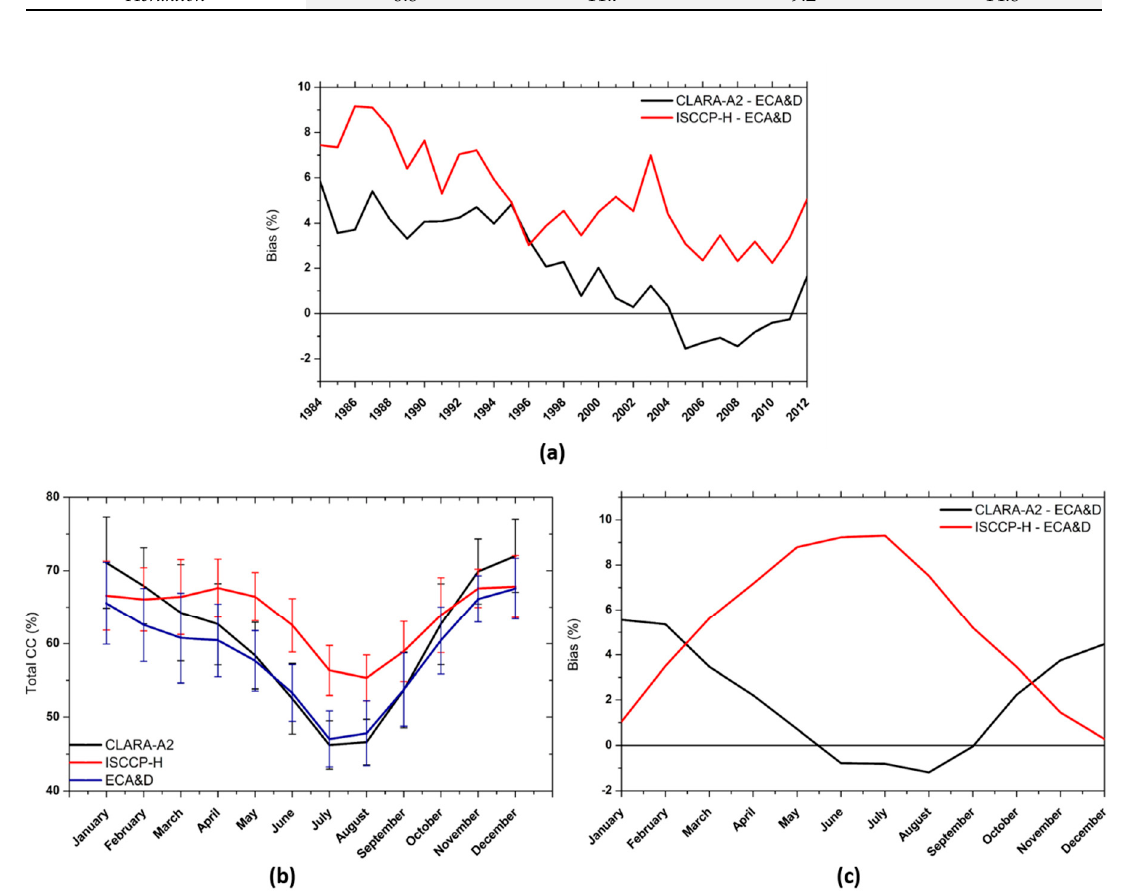
Figure 8. ( a ) Mean annual TCC and ( b ) seasonal variation of TCC averaged over all ECA&D stations and the average of the corresponding grid cells of ISCCP-H and CLARA-A2 for their common period (1984–2012). Vertical bars denote the year-to-year variability of monthly TCC values. ( c ) Seasonal variation of the bias of CLARA-A2 and ISCCP-H with respect to ECA&D.